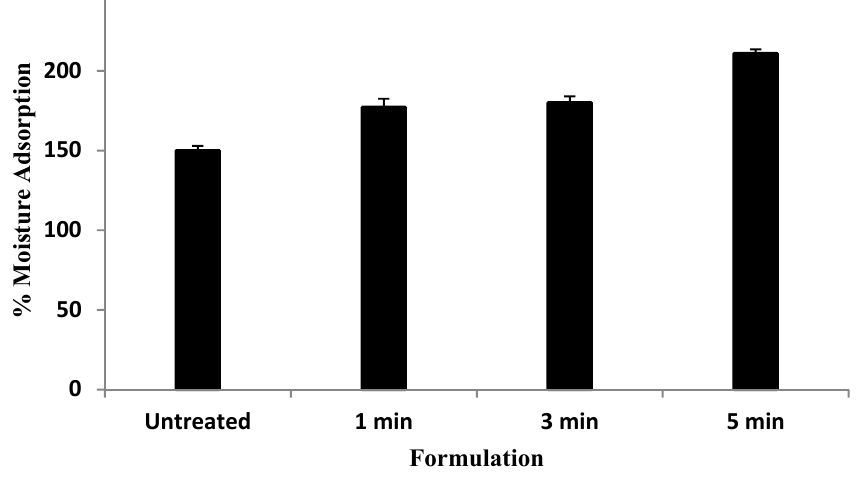
Figure 1. Percent moisture adsorption of various blend films.